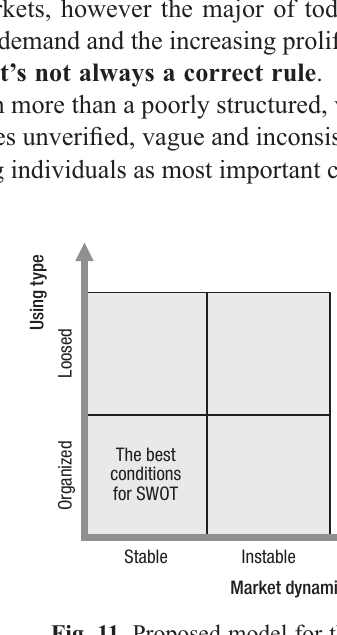
Fig. 11. Proposed model for the best conditions for